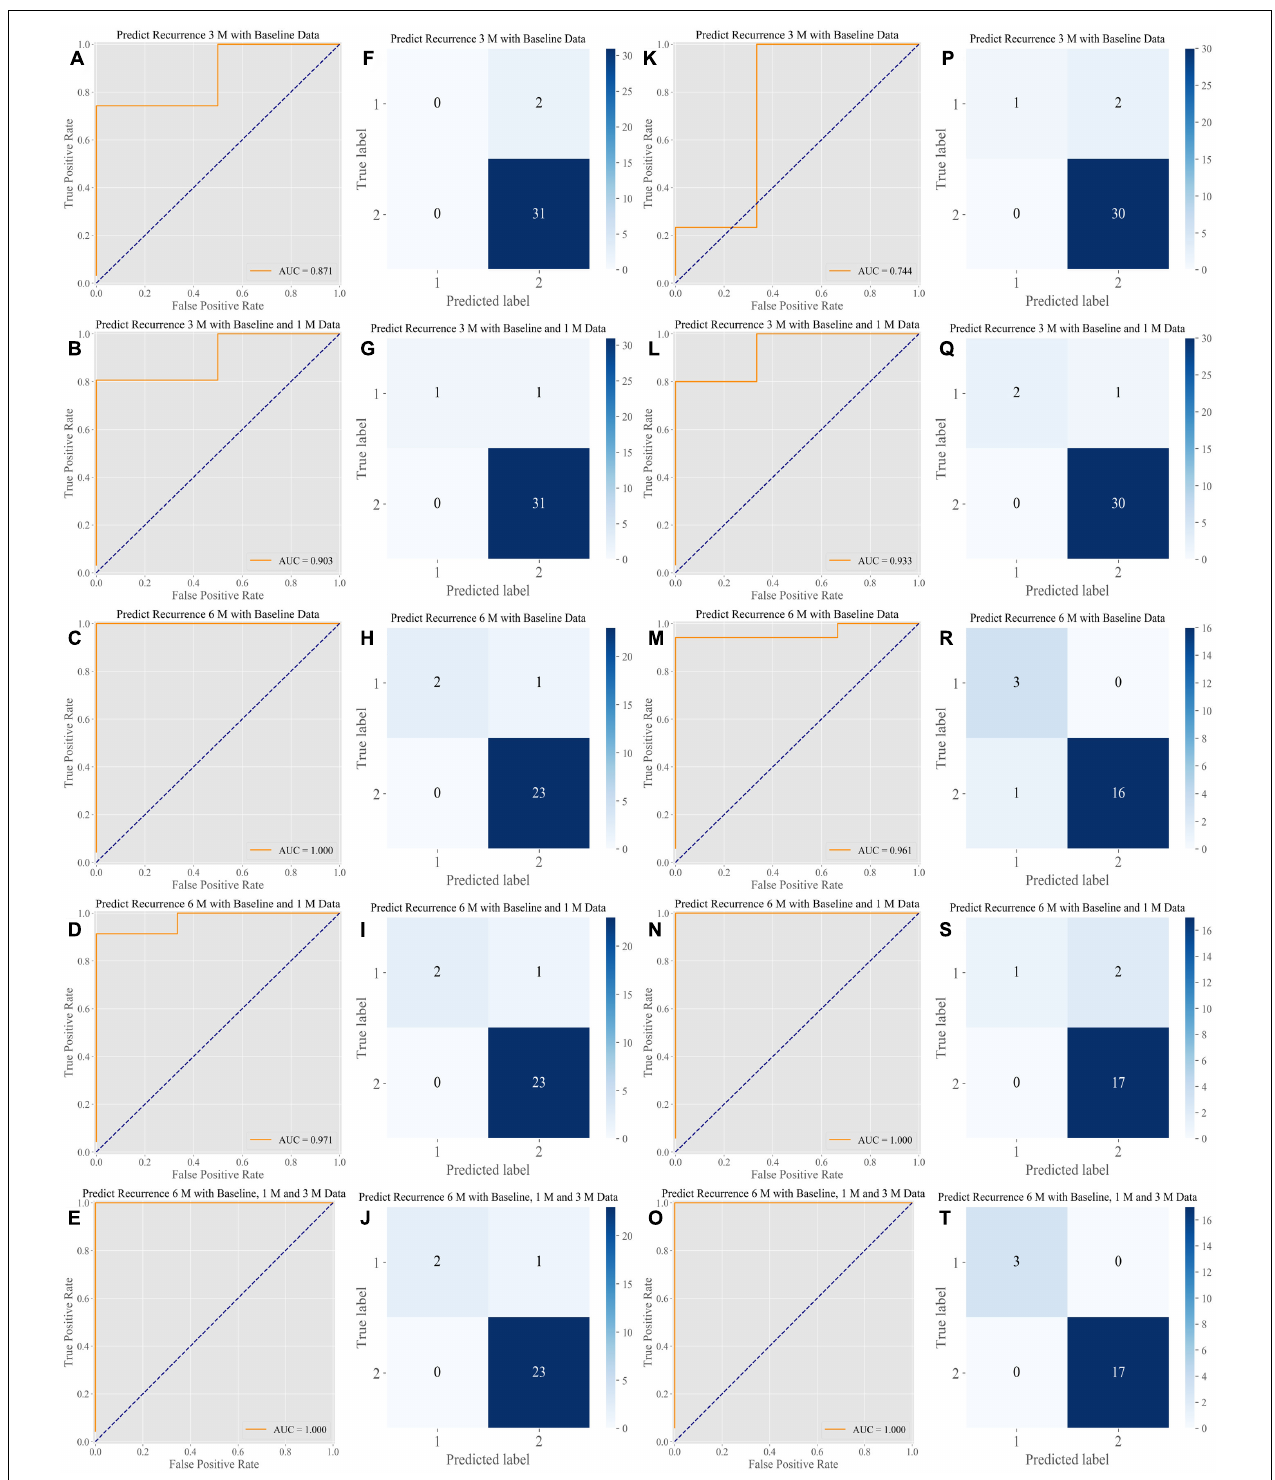
FIGURE 2 | Performance of the algorithms in the internal test dataset and the External Test Dataset of the Full Model. Our algorithms presented a stable and high level of accuracy in all prediction tasks. (A–E) ROC analysis of the performance of the algorithms in the internal test dataset. The AUCs ranged from 0.871 to 1.000 for predictions obtained at 3 and 6 months, respectively. (F–J) CM of the classification provided by the algorithms in the internal test dataset. (K–O) ROC analysis of the performance of the algorithms in the external test dataset. The AUCs ranged from 0.744 to 1.000 for predictions at 3 and 6 months, respectively. (P–T) CM of the classification provided by the algorithms in the external test dataset. ROC, receiver operating characteristic curve; AUC, area under the curve; CM, confusion matrix.